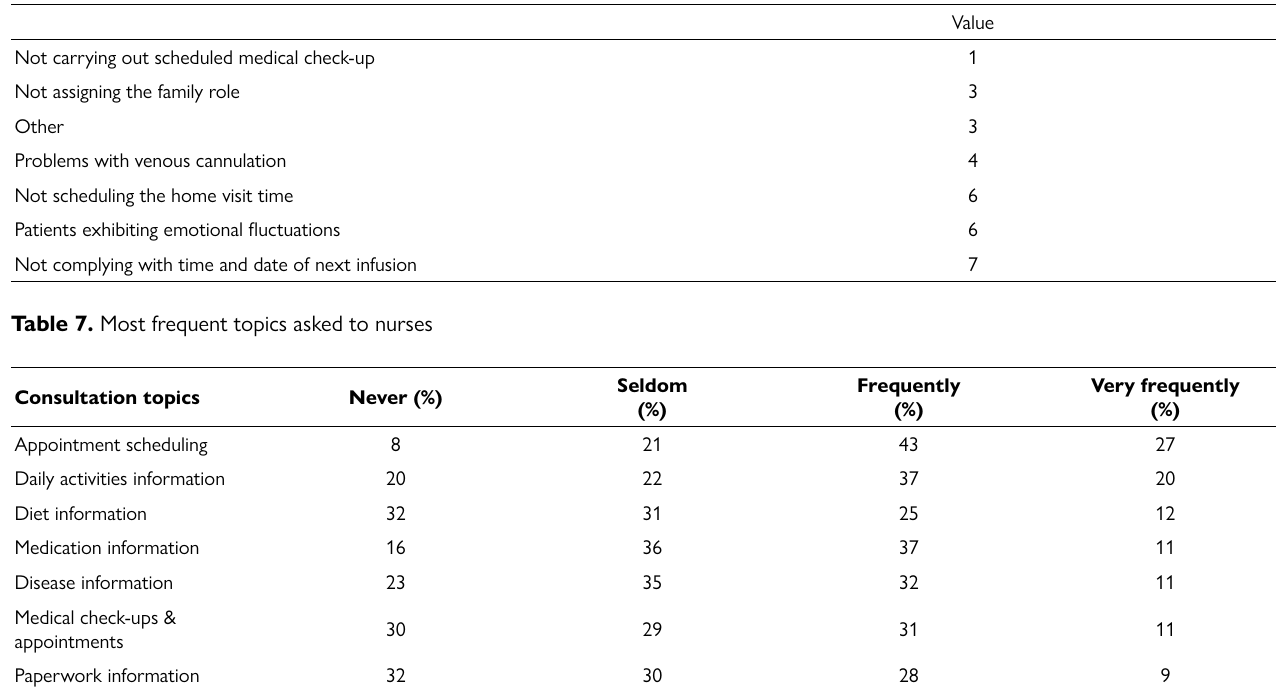
Table 6. Difficulties reported by the nurses during in-home assistance